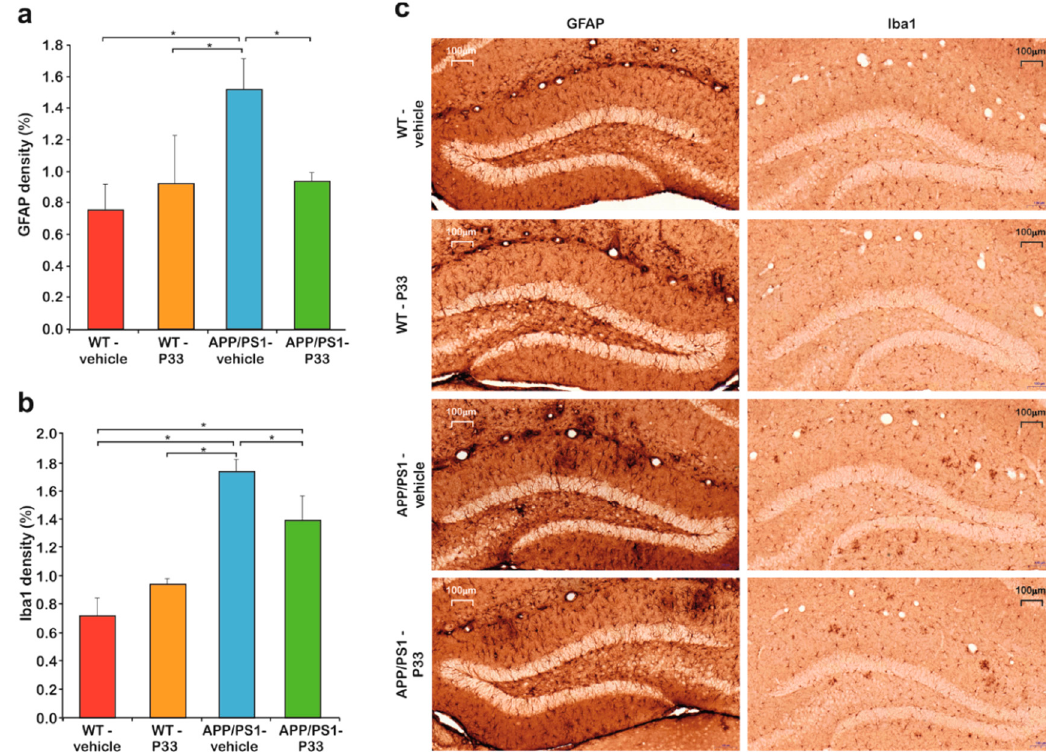
Figure 6. Histology results II. ( a ) Quantitative results of the glial fibrillary acidic protein (GFAP) staining. Significant differences were observed between the groups in the densities of hyperreactive astrocytes ( p = 0.048). An increased GFAP-positive cell density was detected in the APP/PS1-vehicle group compared to the WT-vehicle ( p = 0.009), the WT-P33 ( p = 0.047), and the APP/PS1-P33 ( p = 0.039) ones. * represents significant differences at the corresponding p -levels. ( b ) Results of the ionized calcium-binding adapter molecule 1 (Iba1) immunostaining. A significantly higher level of the activated microglia density ( p = 0.004) was found in the APP/PS1-vehicle animals than in the other groups (WT-vehicle: p = 0.001, WT-P33: p = 0.003, APP/PS1-P33: p = 0.046). * represents significant differences at the corresponding p-levels. ( c ) Representative images of GFAP and Iba1 stainings. Scale bars represent 100 μ m.